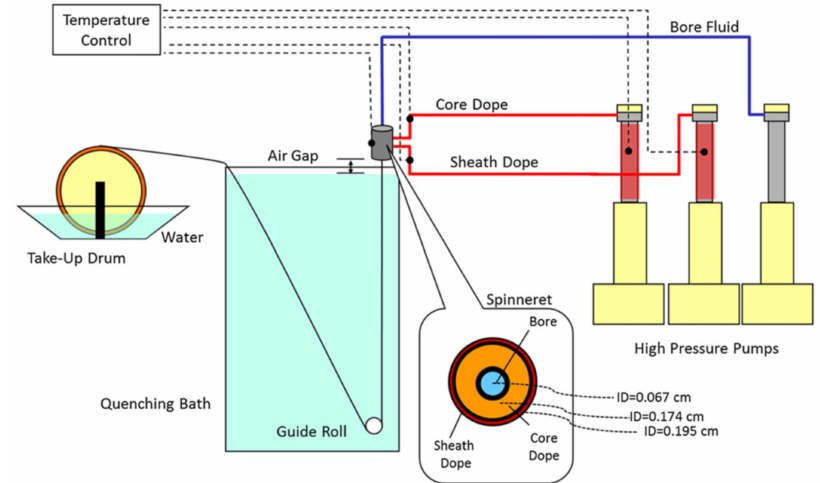
Figure 12. Schematic of the dual-layer spinning apparatus. Reprinted with permission from